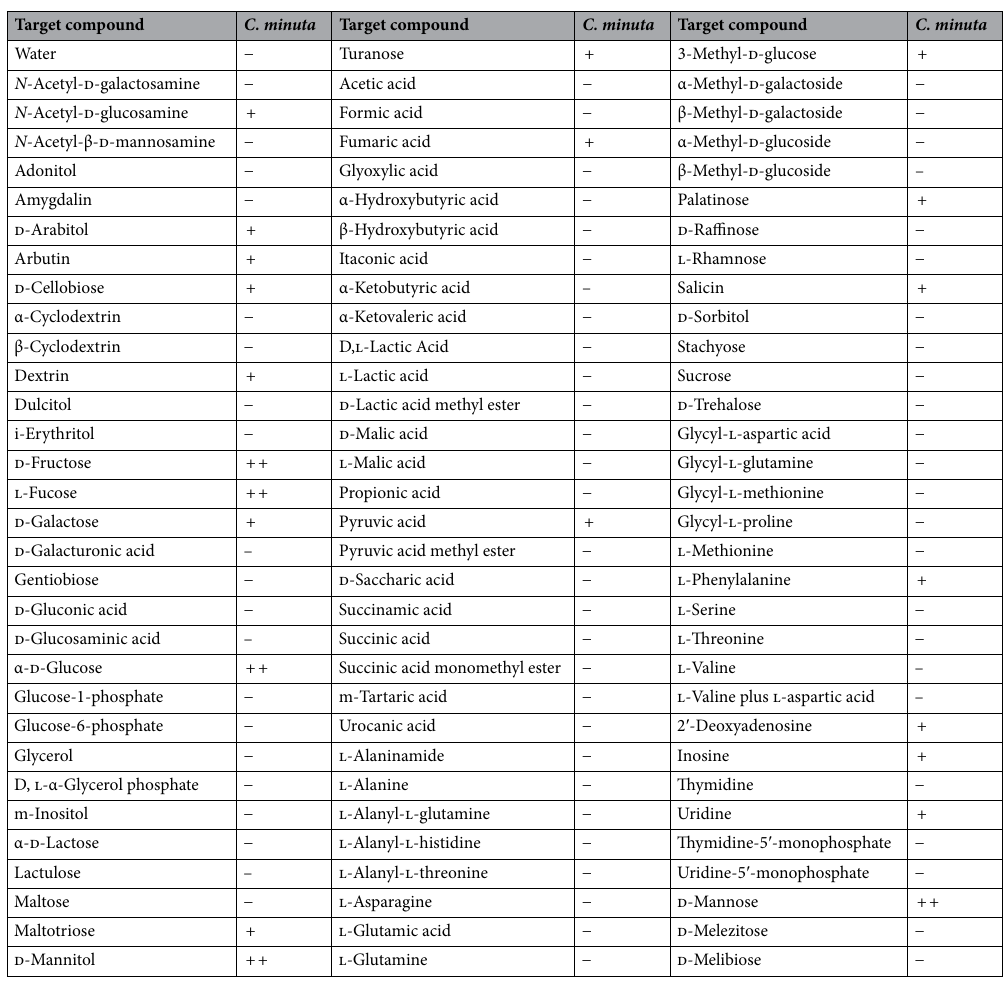
Table 1. Metabolic profile of Christensenella minuta strain DSM